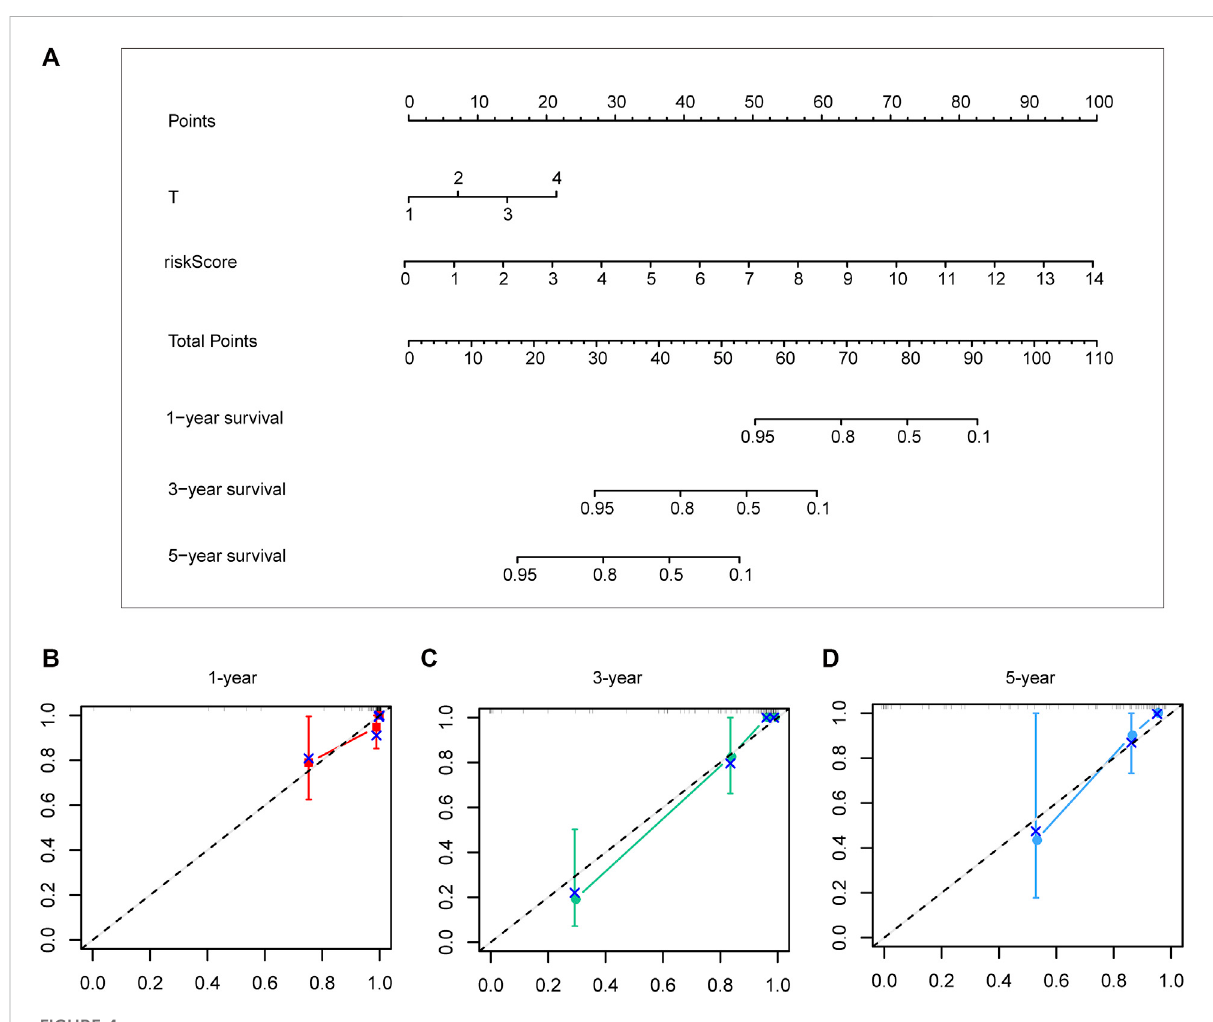
FIGURE 4 A nomogram constructed by clinical T stage and riskscore in test cohort (A) . Calibration curve predicting 1-, 3-, and 5-year patient prognosis (B – D)